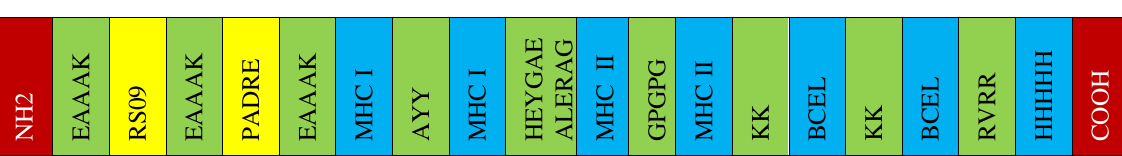
Figure 4. Graphical representation of the Final vaccine construct. (Green: Linkers, Yellow: adjuvant, Dark red: N and C terminal sites, Blue: The chosen peptides for the